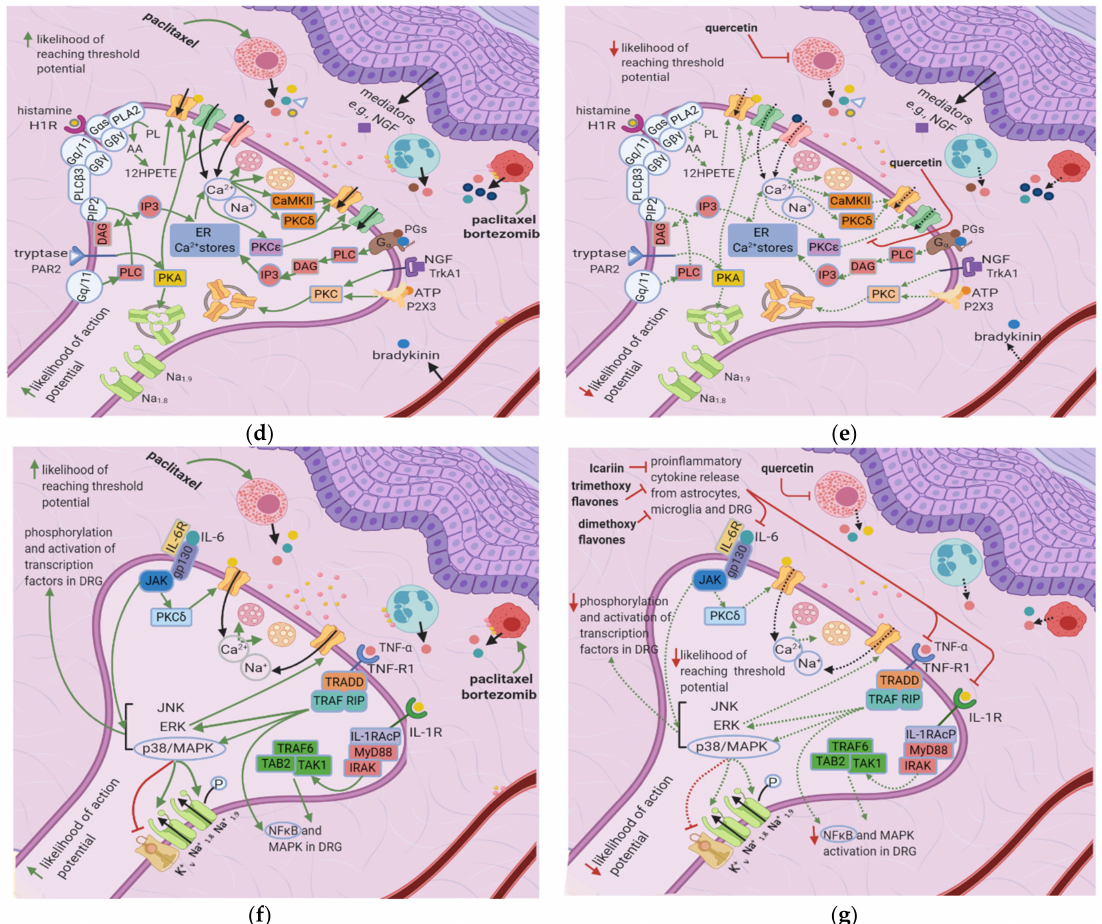
Figure 3. Effects of anticancer drugs and flavonoids at the peripheral nociceptor. ( a ) Simplified Overview. Flavonoids counter anticancer drug induced nociceptor sensitization. Anticancer drugs, via the enhanced release of proinflammatory cytokines and activation of ion channels, sensitize the nociceptor, increasing the likelihood that the membrane potential will reach the threshold potential. Thus, there is a greater chance that action potentials will result from weak stimuli that under normal conditions would not reach the threshold potential. ( b ) Effects of anticancer drugs on the peripheral nociceptor. Anticancer drugs increase the release of proinflammatory mediators such as TNF- α , IL-1 β , IL-6, and histamine. These mediators directly sensitize ion channels and activate the ERK/JNK and p38/MAPK pathways, resulting in the activation of Na +1.8 and Na +1.9 and the inhibition of K +v . Histamine, prostaglandins, and tryptase bind to their respective receptors and activate the PKA and PKC pathways, which increase the membrane density of TRPV1 and Na + v channels. These events ultimately elevate the membrane potential to the threshold value, increasing the likelihood of an action potential; ( c ) Actions of flavonoids counter anticancer drugs’ effects. Icariin and trimethoxy and dimethoxy flavones decrease the release of TNF- α , IL-1 β , and IL-6 from astrocytes, microglia, and the DRG, and thereby downregulate the ERK/JNK and p38/MAPK pathways. This reduces the membrane density of ion channels, and consequently decreases the likelihood of reaching the threshold potential and reduces pain signal transmission; ( d ) Activation of PKA and PKC derivatives by anticancer drugs. Paclitaxel induces the degranulation of mast cells, which release tryptase and other proinflammatory mediators. Tryptase acts on PAR2, leading to PKA activation, the sensitization of TRPV1, TRPA1, and TRPV4, and the increased membrane fusion of Na + v . The sensitization of TRP channels increases Na + and Ca 2+ inflow into the nociceptor. Ca 2+ causes vesicles to fuse with the membrane and activates PKC δ , CaMKII, and PKC ∈ , which activate TRPV4 and TRPV1, further increasing ion inflow. These events increase the likelihood that the membrane potential will reach the threshold potential; ( e ) Flavonoids prevent neuropathic pain, affecting PKA and PKC derivatives activation. Quercetin inhibits the translocation of PKC ∈ from the cytoplasm to the membrane and prevents paclitaxel-induced mast cell degranulation. Thus, there is less activation of PKA and PKC derivatives, which leads to decreased channel activation, less ionic influx, and a reduced likelihood that the membrane potential will reach threshold potential; ( f ) Anticancer drugs lead to the release